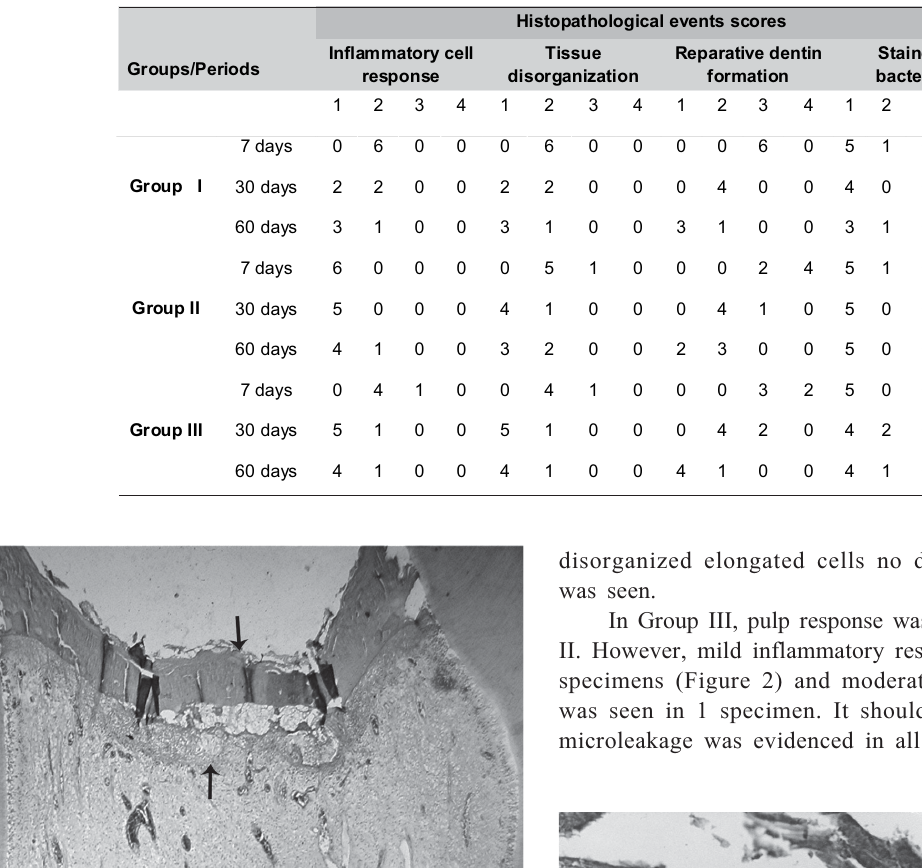
Table 5. Number of teeth for each score according to groups and periods